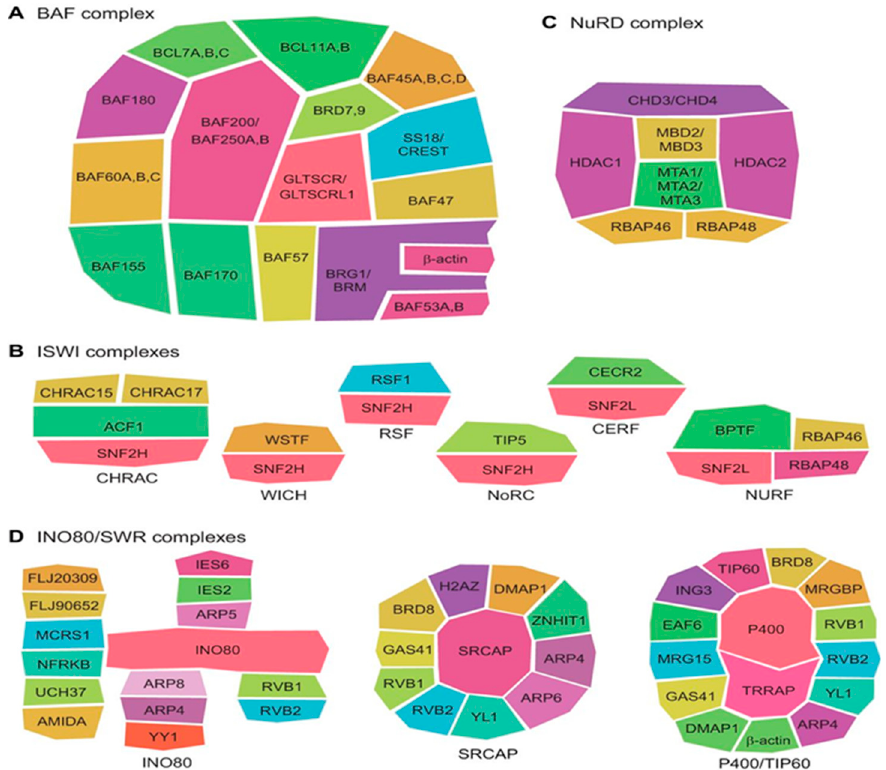
Figure 2. Subunit organization of different ATP-dependent chromatin remodeling complexes.